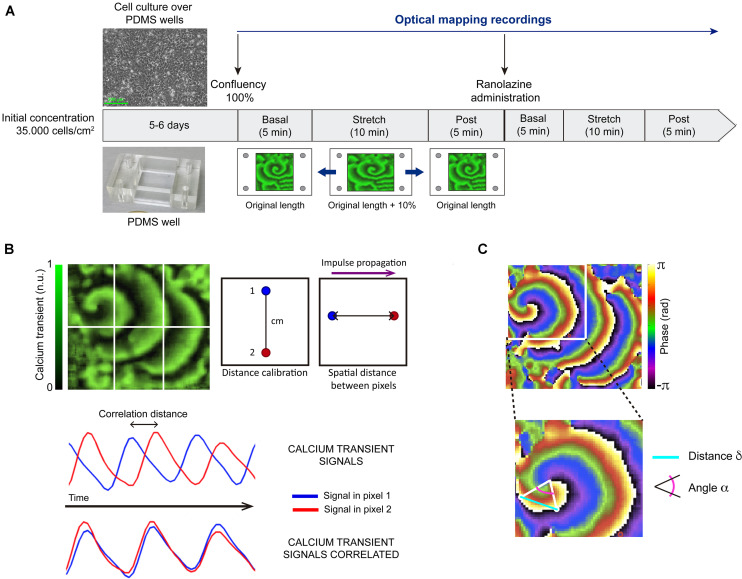
Summary of methodology. (A) Outline of the experimental protocol: after achieving cell confluence, optical mapping recordings were acquired each minute during the basal situation (5 min), under stretching to 110% of resting length (10 min), and after stretch suppression (5 min). The same protocol was repeated in the presence of ranolazine. (B) Process for calculating conduction velocity: calibration distance, pixel selection, correlation of fluorescence signal in time of pixel 1 and pixel 2, and conduction velocity obtained as the ratio spatial distance (cm)/correlation distance (s). n.u.: normalized units. (C) Approach for estimating curvature: transition lines from 0 to 2π selection, relative angle (α) and distance (δ) calculation, and curvature of the rotor measured as the spatial derivative of alpha (dα/dδ).